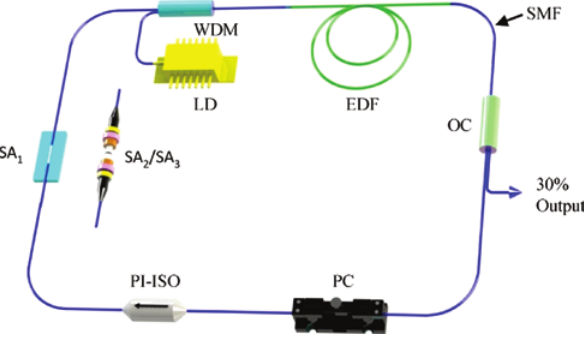
Figure 3: Pulsed fiber laser based on PbSe SAs. Laser diode: LD; wavelength division multiplexer: WDM; erbium- doped fiber: EDF; optical coupler: OC; single-mode fiber: SMF; polarization controller: PC; polarization-independent isolator: PI-ISO; DSF-PbSe: SA ; FF-PbSe: SA ; PVA-PbSe: SA 1 2 3